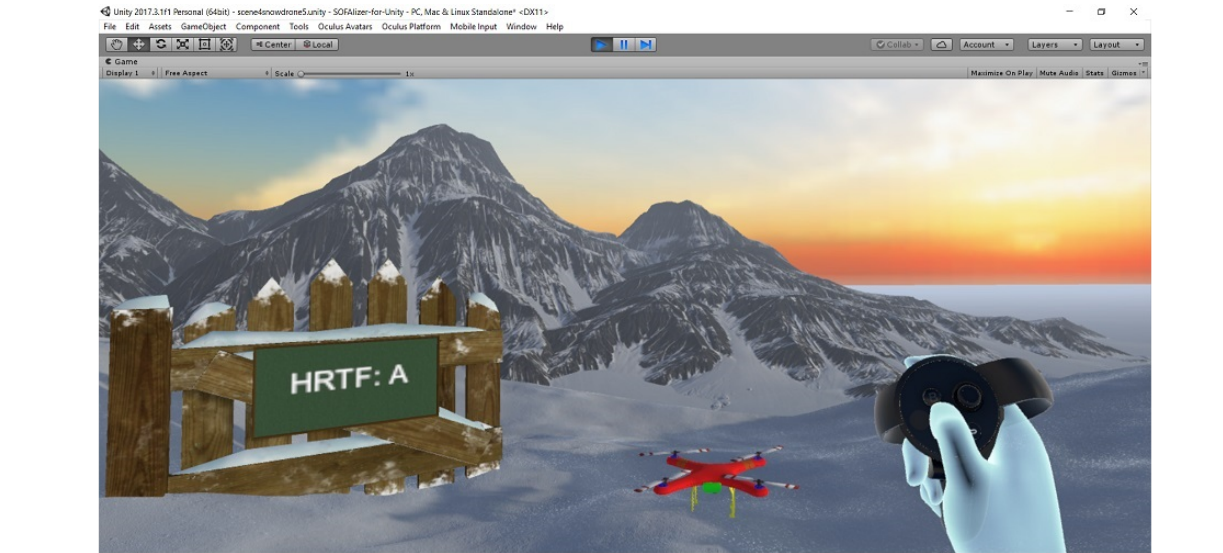
Figure 3. Experimental environment in first-person view: winter landscape scene with drone, board for the display of head-related transfer function (HRTF), and touch controllers for